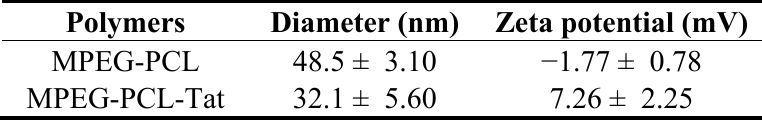
Table 1. Particle diameter and zeta potential of MPEG-PCL and MPEG-PCL-Tat.